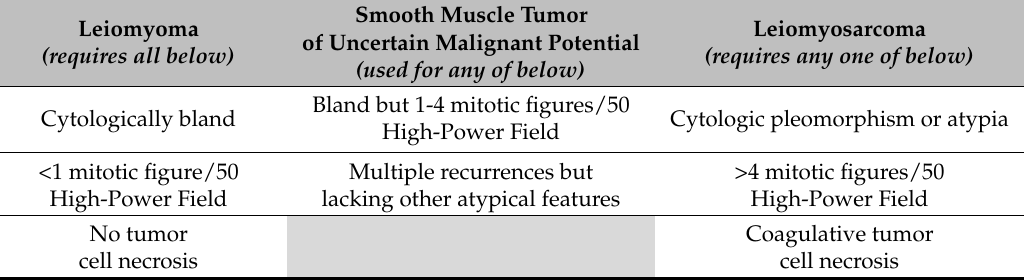
Table 3. Leiomyosarcoma of Deep Soft Tissue Stanford Medicine Surgical Pathology Criteria [55].